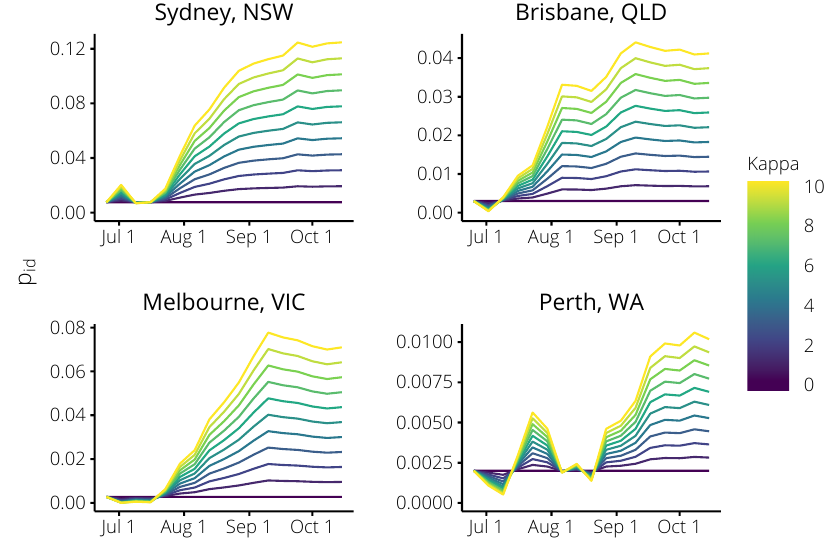
Figure 6. The trend in the testing probability p id ( w ) at each week of the 2017 season, shown here for each city and over a range of values for κ . When κ = 1 the (relative) change in p id ( w ) is the same as the (relative) change in the Flutracking testing probability; when κ > 1 p id ( w ) is more sensitive to changes in the Flutracking testing probability; and when κ = 0 we recover the non-calibrated forecasts (which do not account for any behaviour